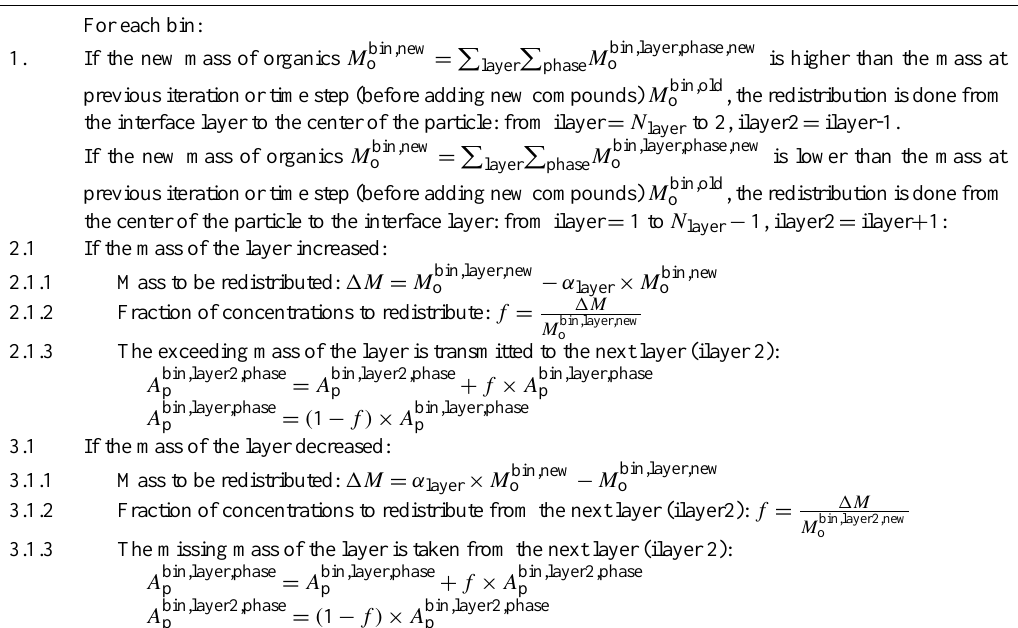
Table 3. Algorithm to compute the redistribution of compounds between